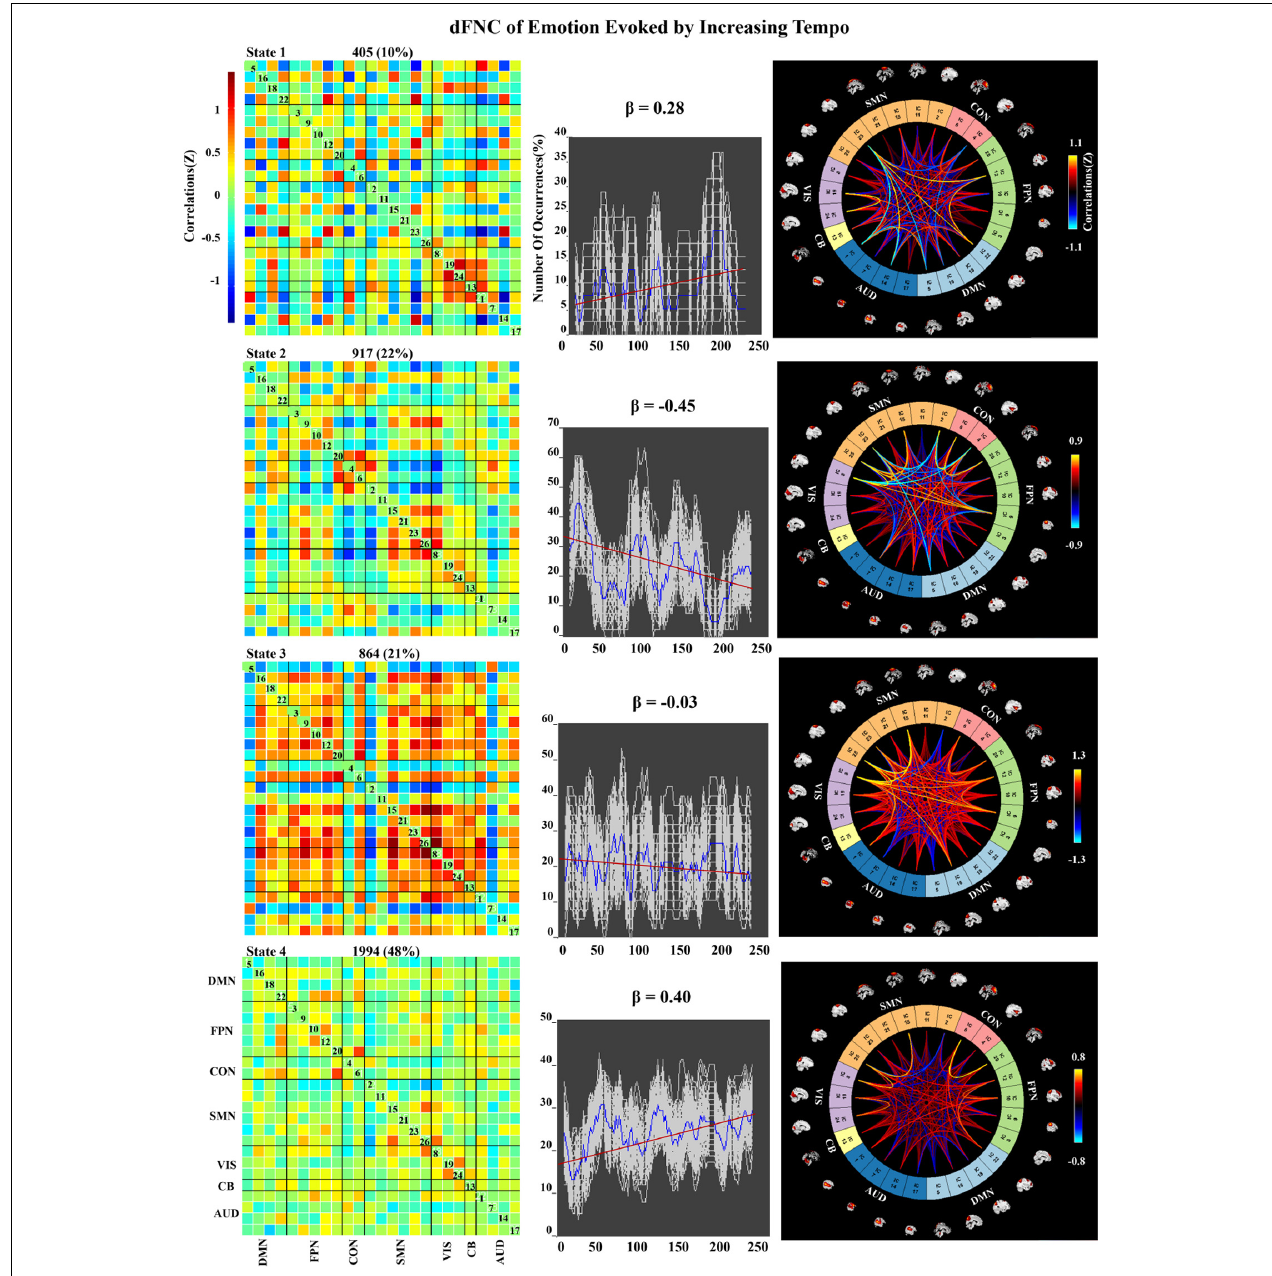
FIGURE 8 | Correlation matrix, number of occurrences, and connectograms of four clusters of evoked emotion by increasing -tempo music.